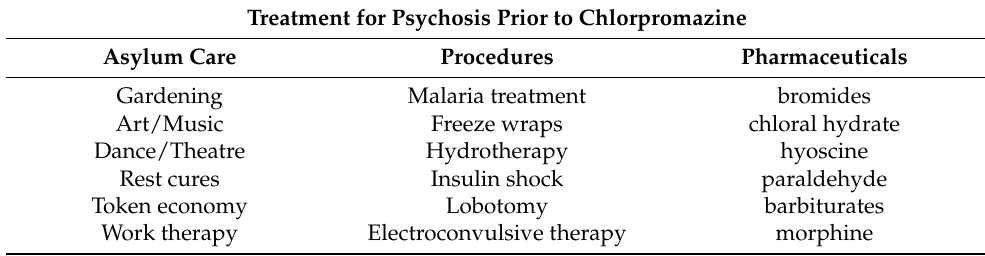
Table 1. Treatment of delusional disorder before the introduction of